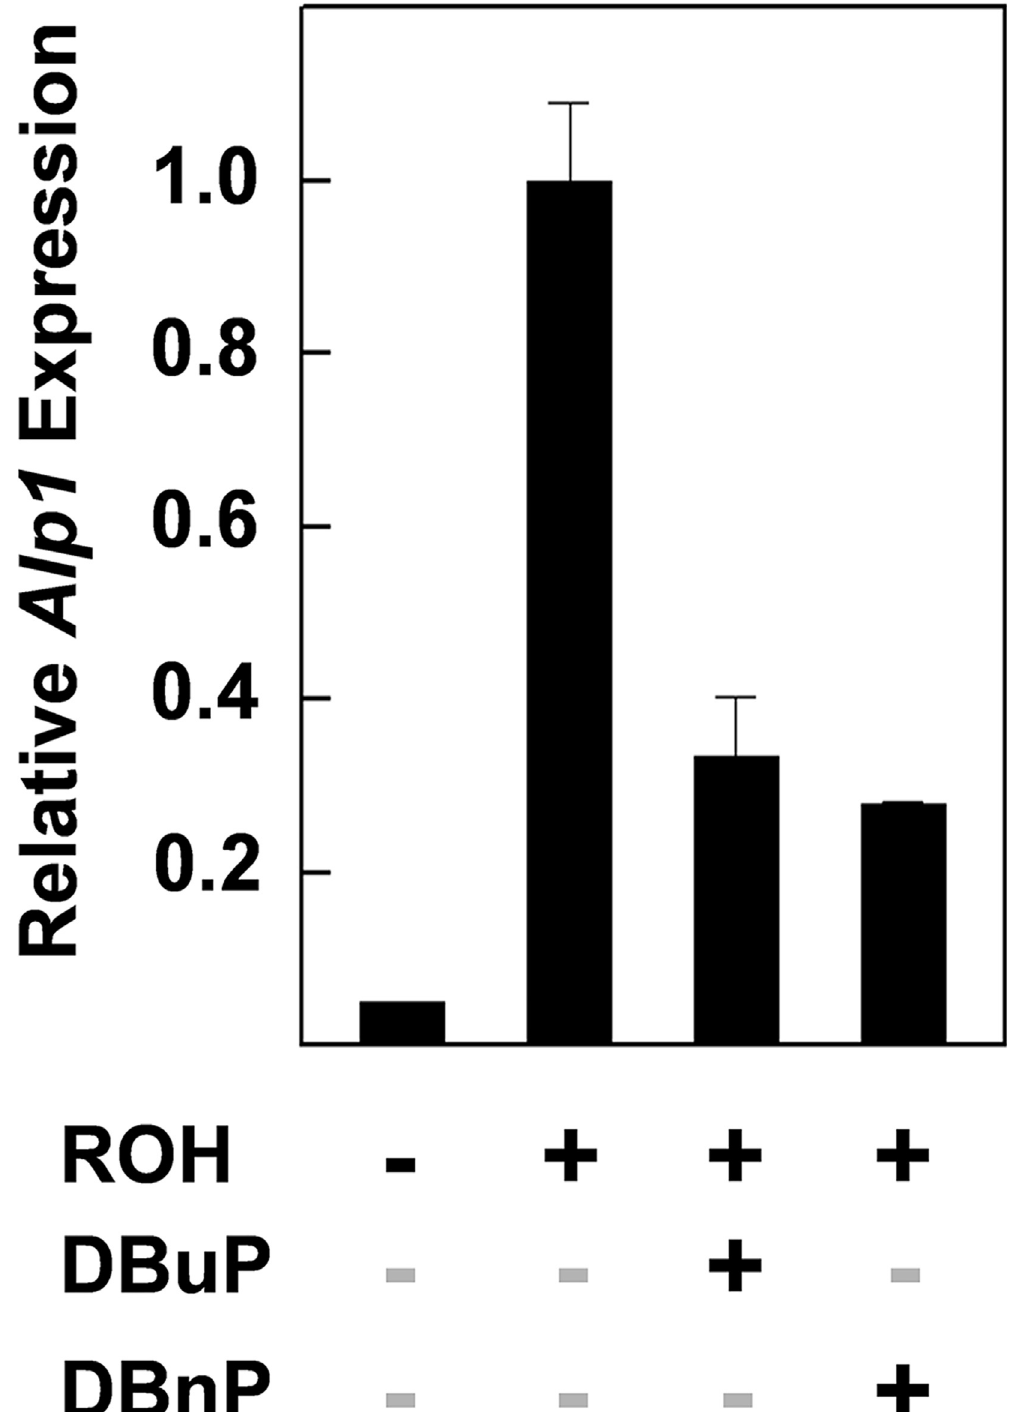
Fig 6. Effects of DBuP and DBnP on the induction of Alp1 expression by ROH in C3H10T1/2 cells. 7 h screen. The final PE and ROH concentrations were 45 μ M and 0.3 μ M respectively. n = 2.